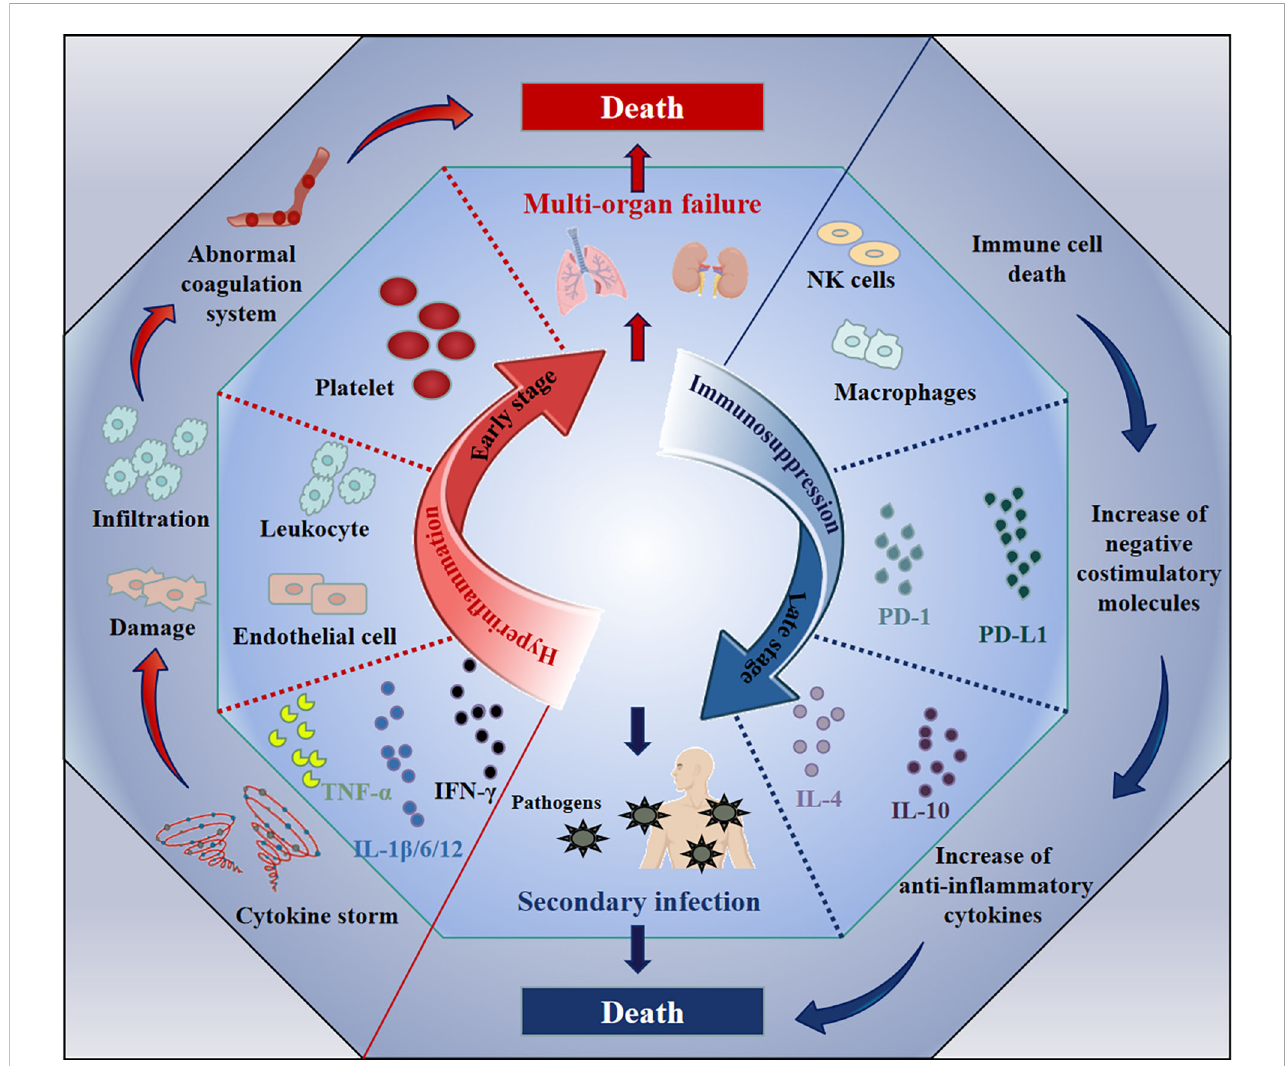
FIGURE 1 The immune changes during the pathological process of sepsis. The immunological abnormity exhibits two distinct stages accompanying with the sepsis development: hyperin fl ammation and immunosuppression. During the hyperin fl ammatory phase at early, the increase of pro-in fl ammatory cytokines (e.g., IL-1 b /6/12, IFN- g , and TNF- a ) leads to cytokine storm, resulting in the vascular system damage (e.g., endothelial cell damage), the abnormal coagulation, fi nally multi-organ failure and death. Subsequently, the death of immune cells, the increase of negative costimulatory molecules (e.g., PD-1 and PD-L1) or anti-in fl ammatory cytokines (e.g., IL-4 and IL-10) induces immunosuppression, which leads to uncontrolled secondary infection and